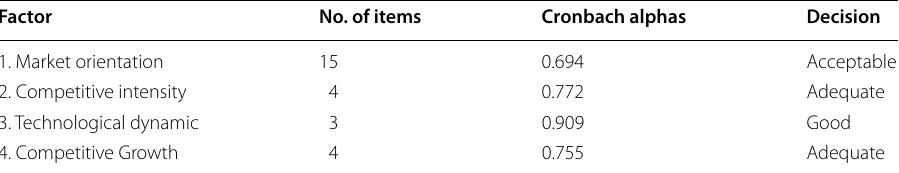
Table 2 Reliability outputs (final list of factors after running Cronbach alpha and EFA)